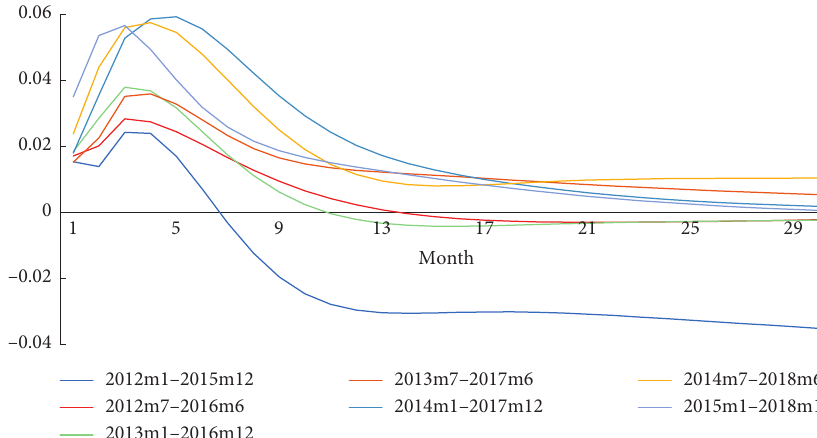
Figure 9: Response of Brent oil prices to a PHD